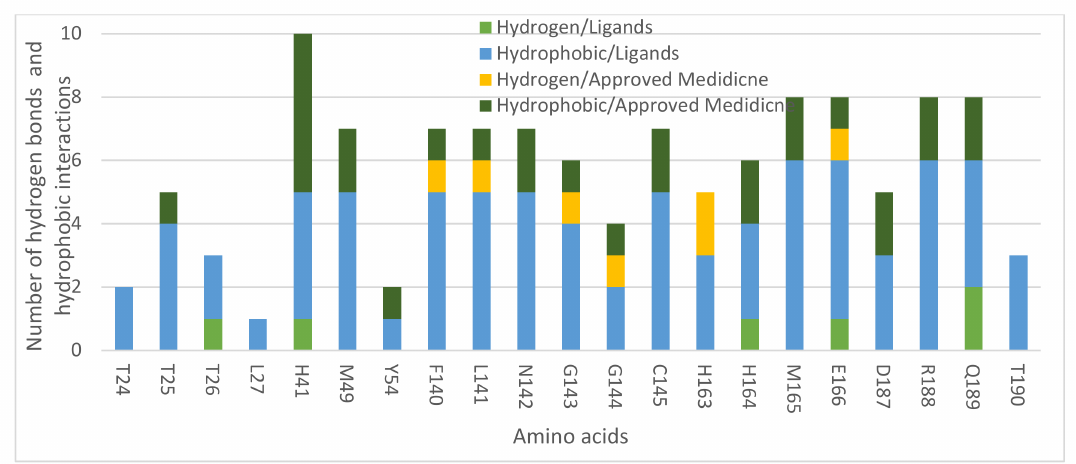
Figure 5. The numbers of hydrophobic interactions and H-bonds revealed upon docking 7BQY protease against compounds 3a–f and the approved drugs.